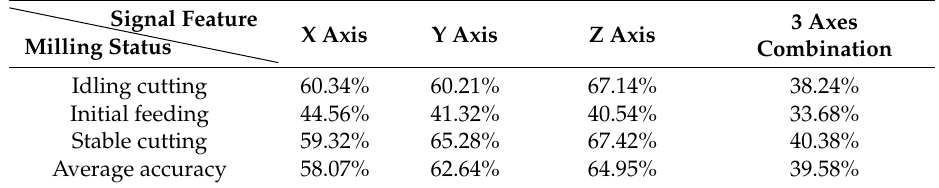
Table 2. Identification result using all features, including features not related to rotation speed.